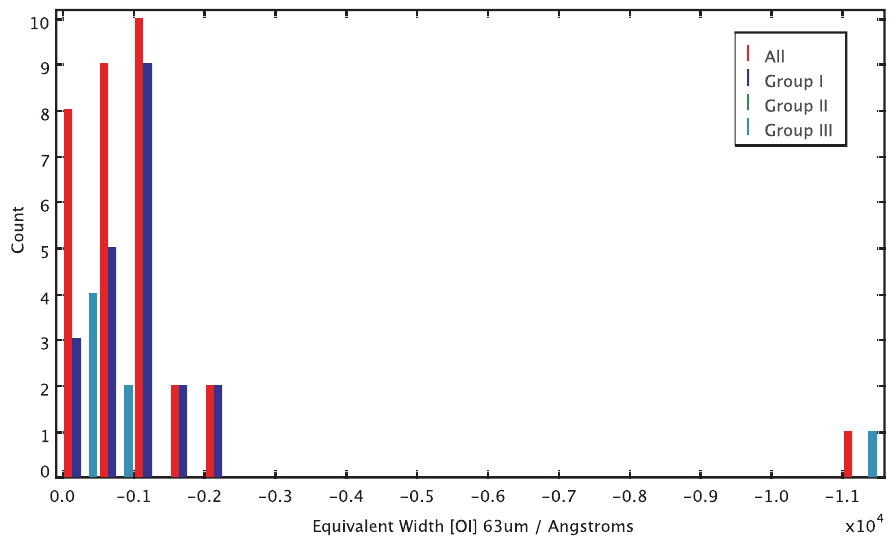
Fig. 3. Histogram of [O I] 63 (cid:22) m equivalent widths showing the SED groups: group I (blue), group II (green) and group III (cyan). The histogram for all sources is shown in red, four sources having unclassi(cid:12)ed SEDs (no IRAS or 2MASS photometry).